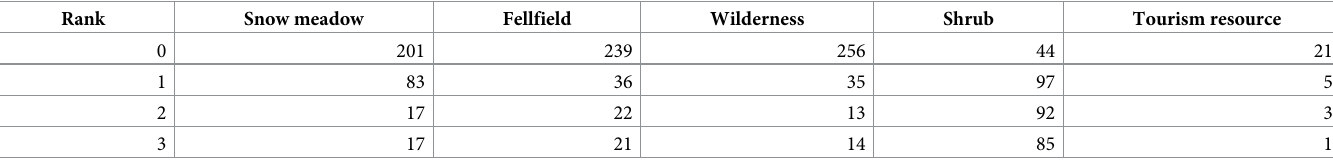
Table 2. Number of cells in each rank for each type of vegetation and ecosystem service. Rank Snow meadow Fellfield Wilderness Shrub Tourism